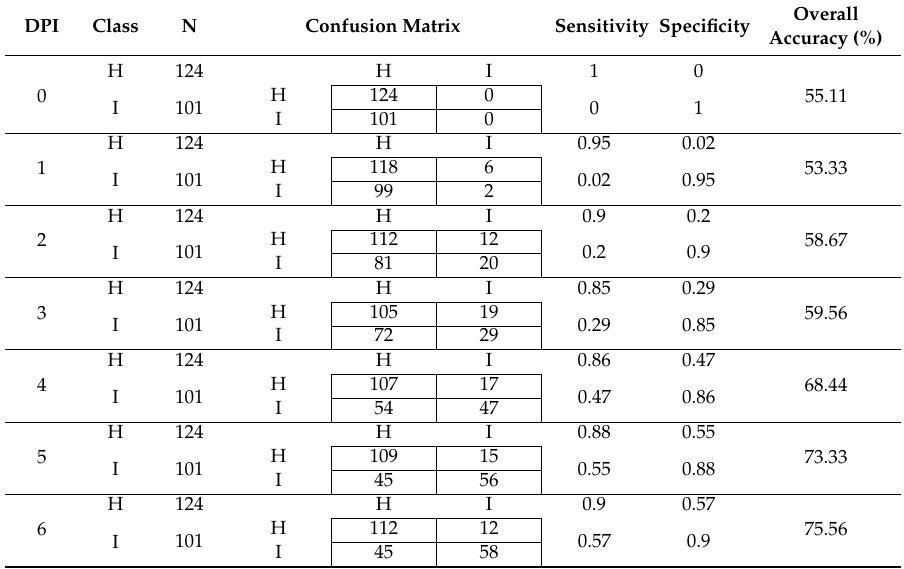
Table 5. Confusion matrix and related statistics when a linear Support Vector Machine (SVM) classifier is applied to the red-edge point (REP) wavelength to classify 124 healthy and 101 infected leaves as a function of the number of days post-inoculation